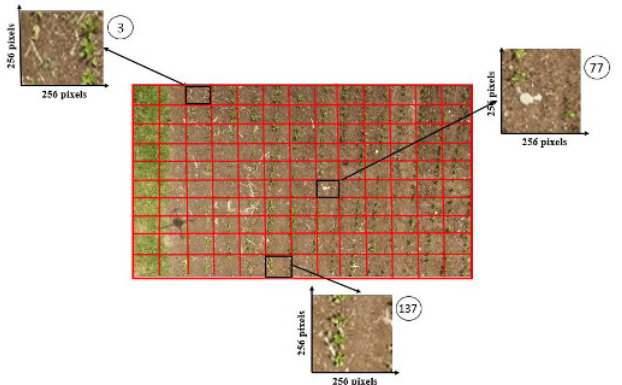
Fig. 2. Image patching and